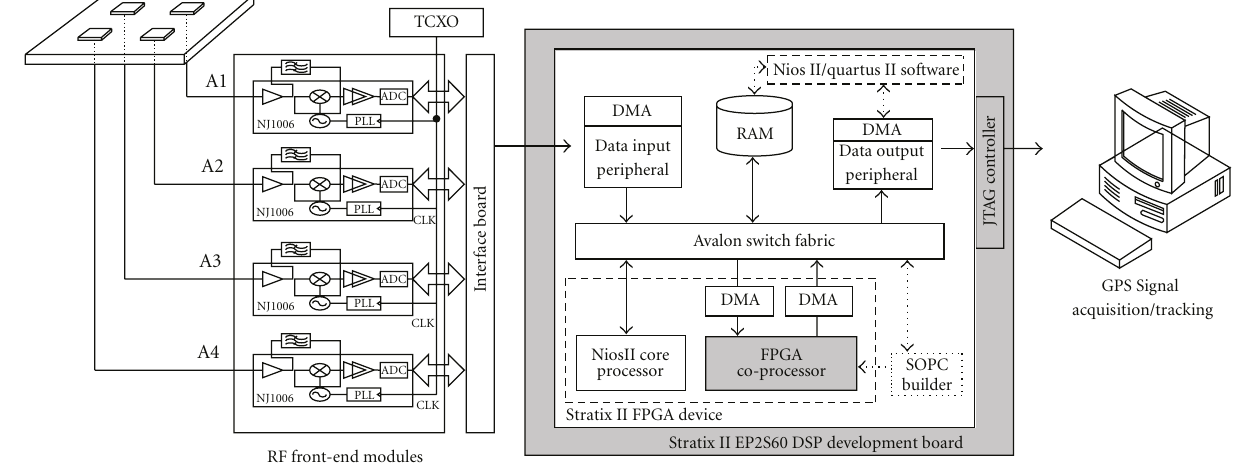
Figure 4: Antenna array experiment